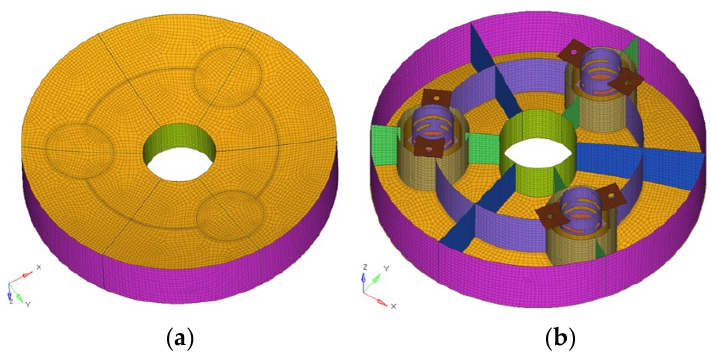
Figure 3. Finite element model of the primary mirror assembly. ( a ) Front view. ( b ) Back view.